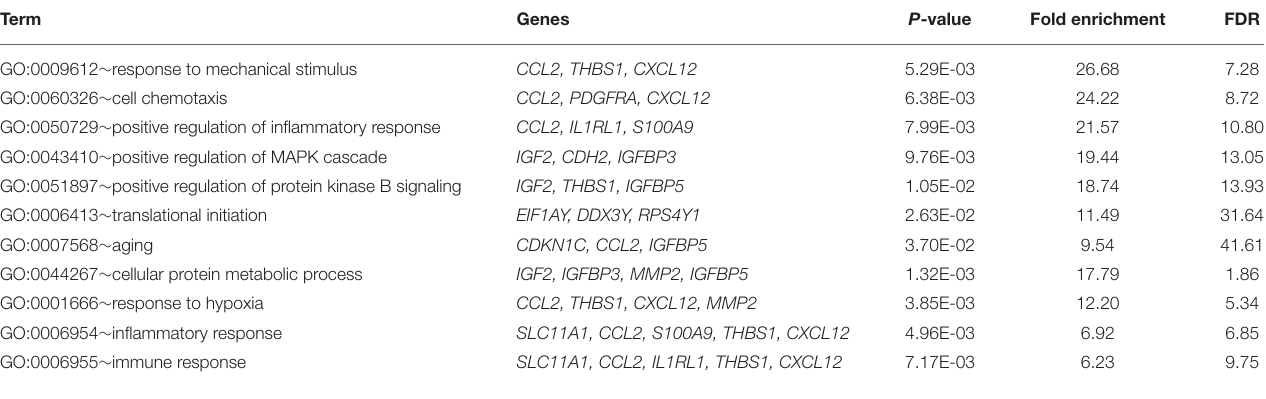
TABLE 1 | Gene ontology analysis for biological process of genes involved in the ceRNA regulation network in ACC. Term